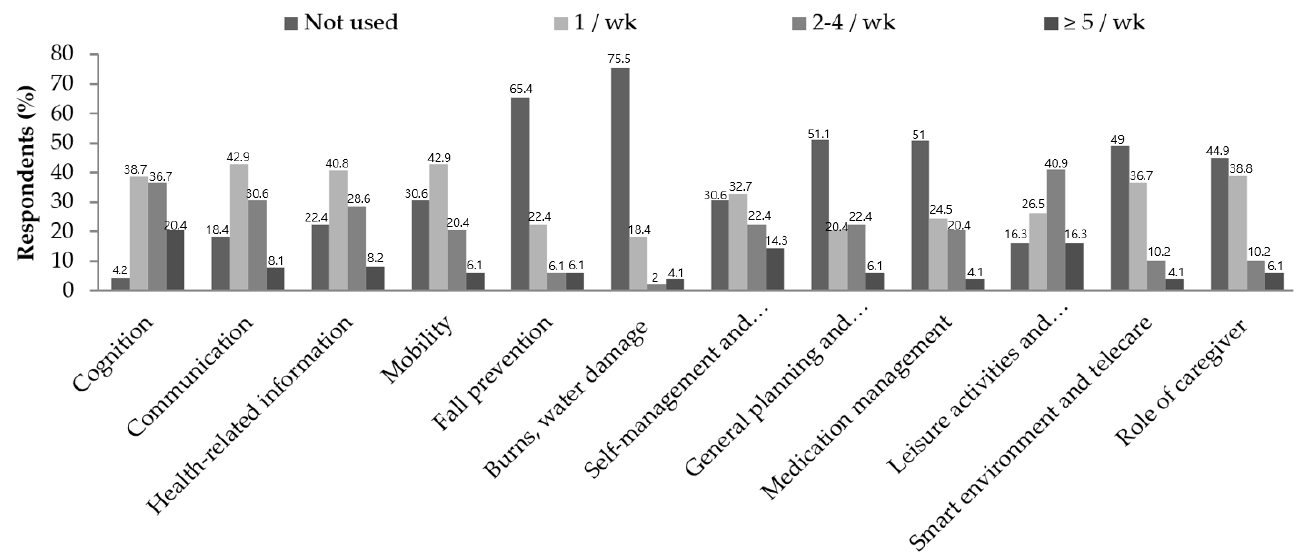
Figure 2. Frequency of ICT use by users.